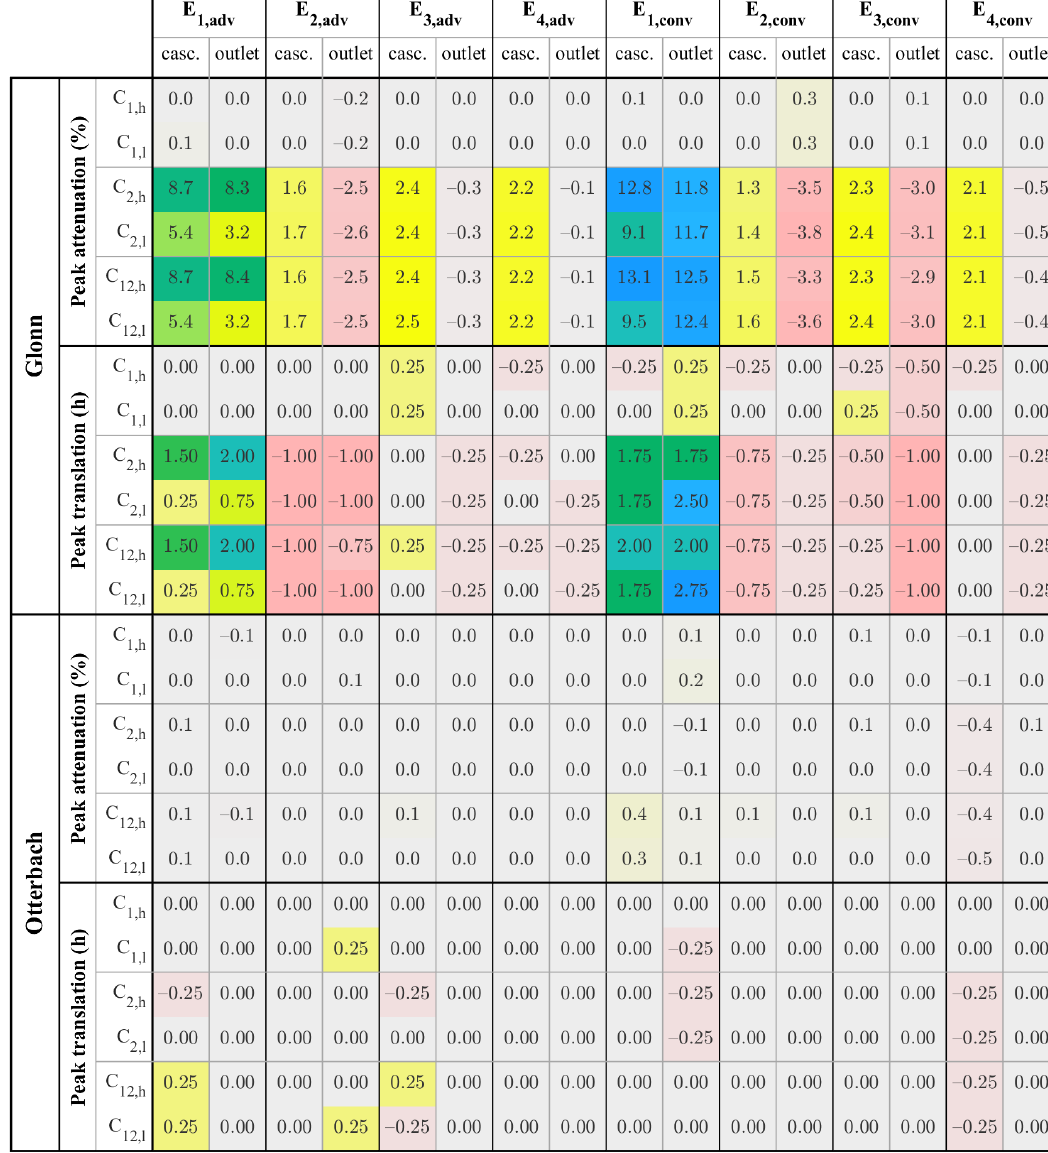
Figure 7. Peak flow attenuations and translations analyzed at the respective beaver dam cascades (local effect) and at the model outlet (regional